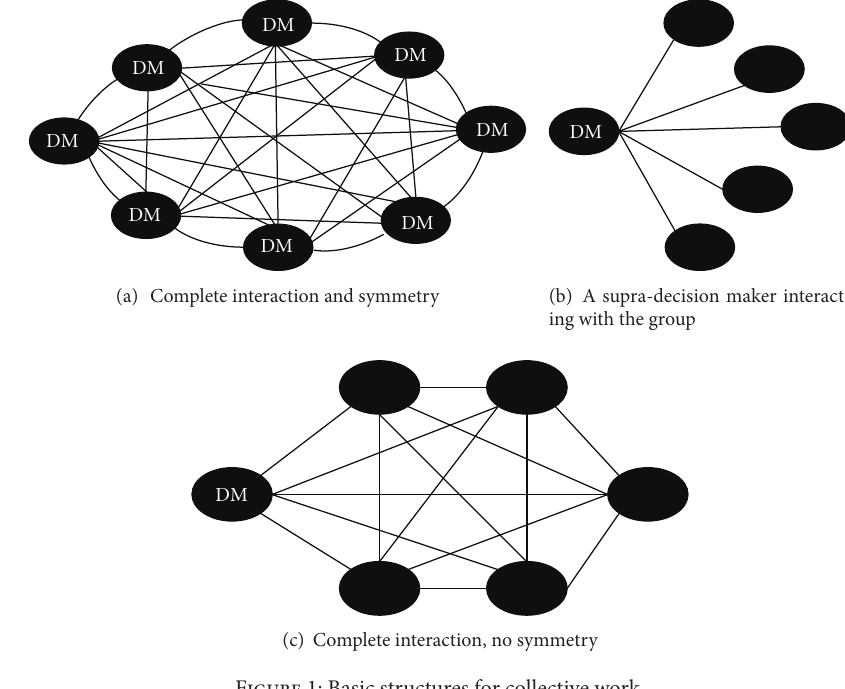
F 1: Basic structures for collective